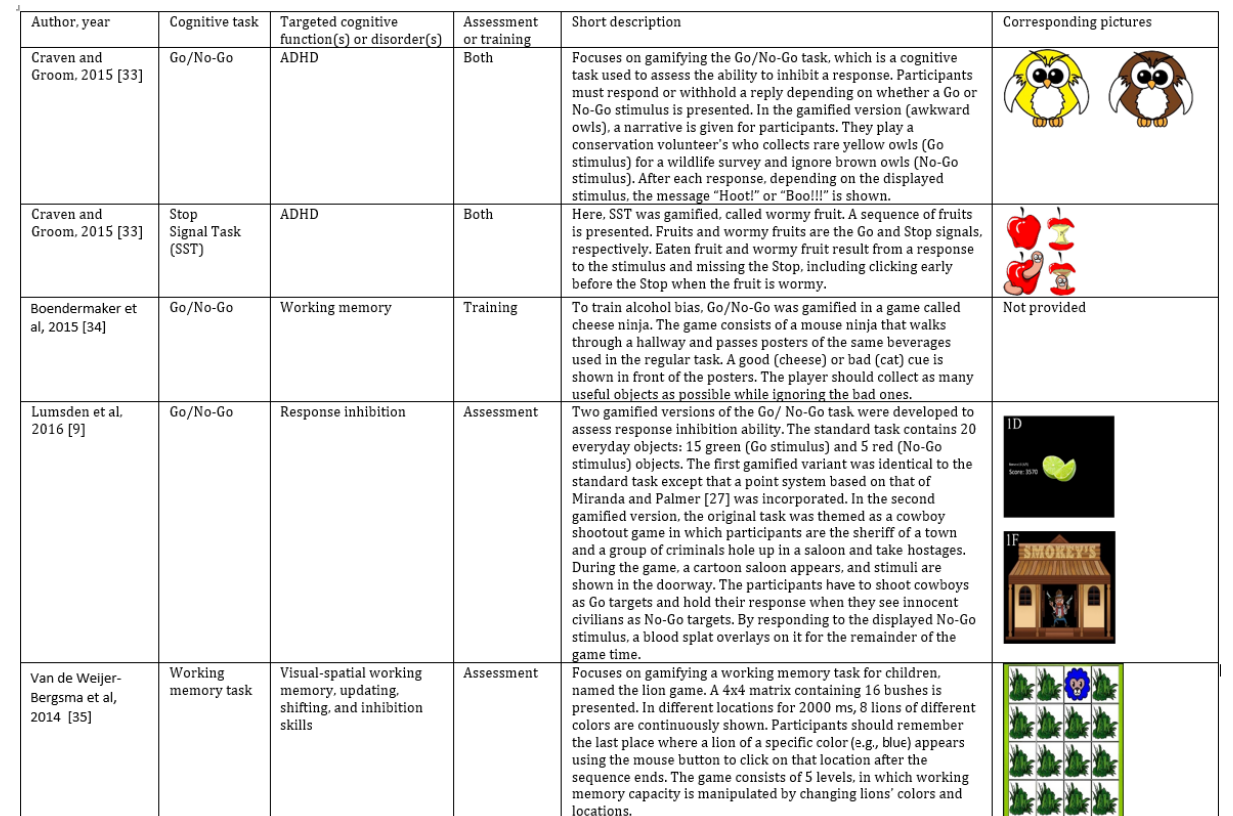
Figure 2. Examples of gamified cognitive tasks. A task was categorized as an assessment or training according to the self-prescription provided by the authors of the publication. The owl and apple pictures were used or adapted by [33] from openclipart [36] and 4vector [37] (online media repository of free graphics). ADHD: attention deficit hyperactivity